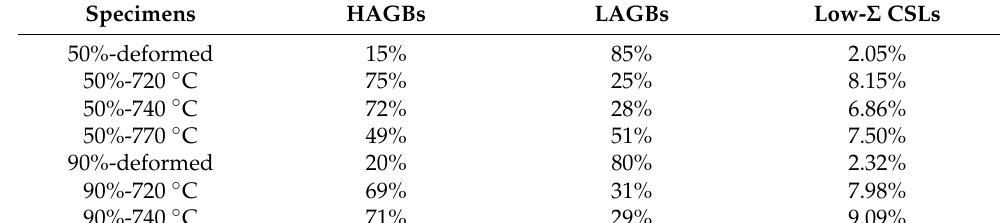
Figure 12. Low- Σ CSL boundary distributions of X2CrNi12 steel at 50% deformation ( a ) and 90% deformation ( b ) with different annealing temperatures. Figure 11. Misorientation distributions of X2CrNi12 steel at 50% deformation ( a ) and 90% defor- mation ( b ) with different annealing temperatures. Table 2. Grain boundary distribution of X2CrNi12 steel specimens.